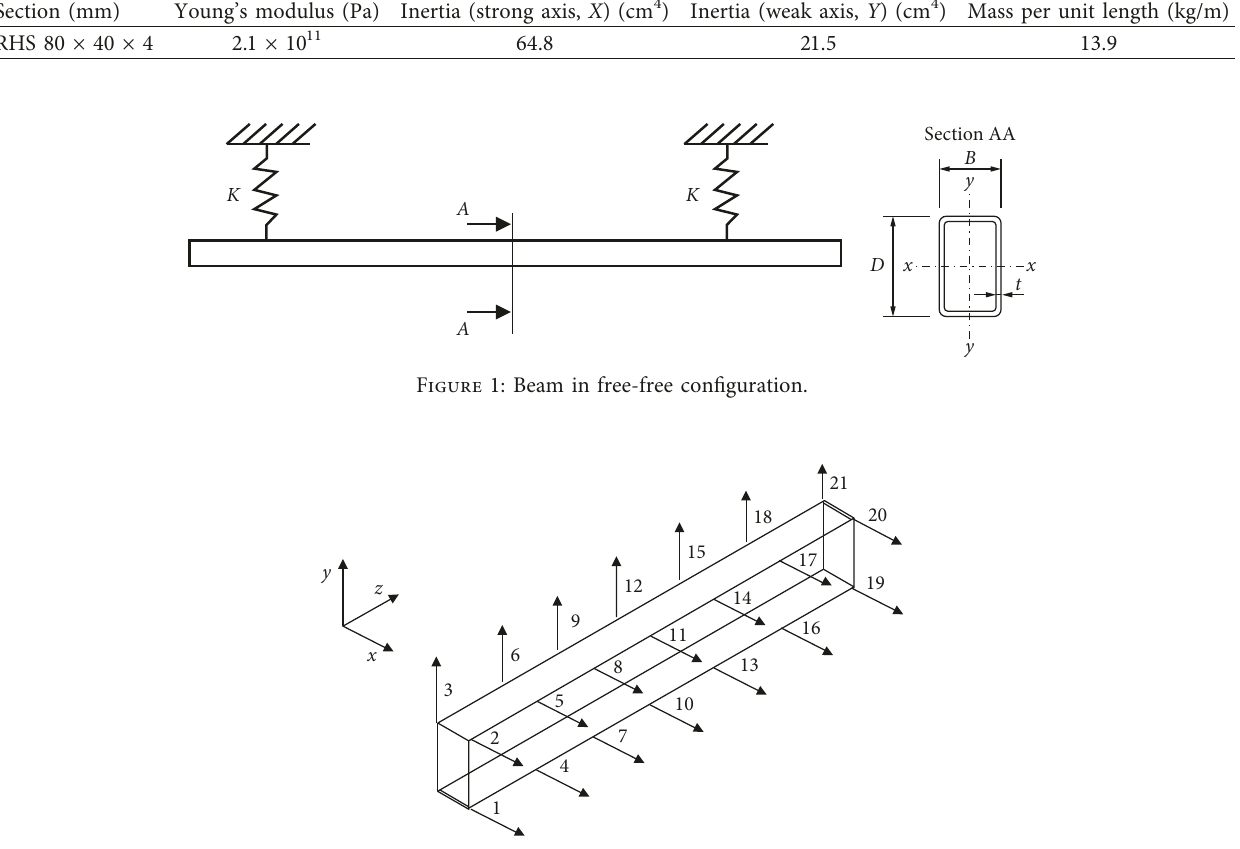
Figure 2: Test setup for the free-free